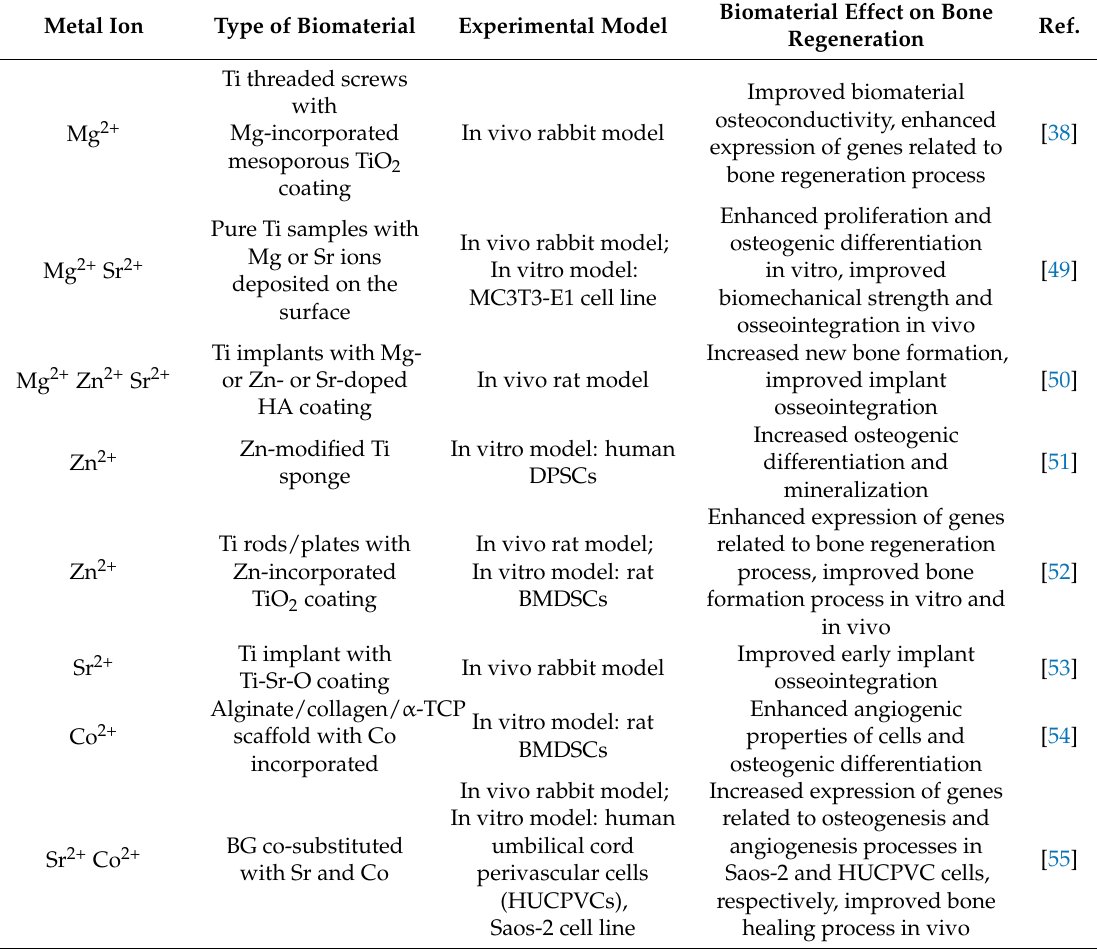
Biomaterial Effect on Bone Regeneration